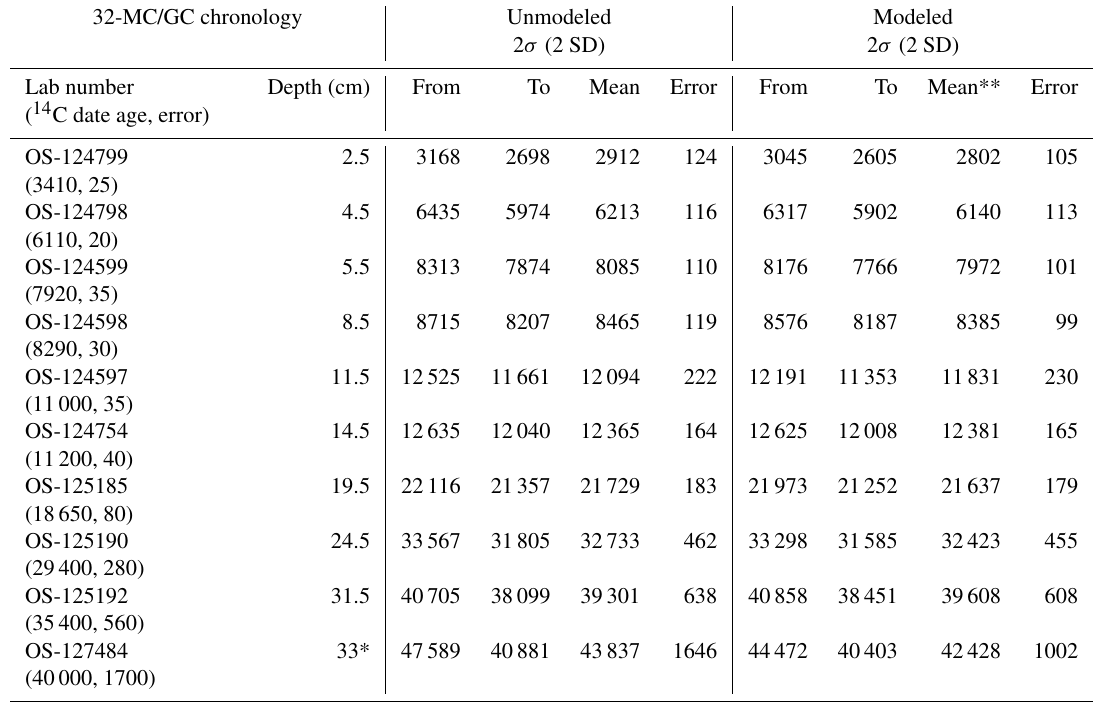
Table 2. Radiocarbon dates for SWERUS 32 cores, uncalibrated 14 C age and calibrated 14 C chronology. All ages as calibrated years BP. (cid:49)R = 300 ± 100 years (Reimer and Reimer, 2001). Marine13 calibration curve (Reimer et al.,